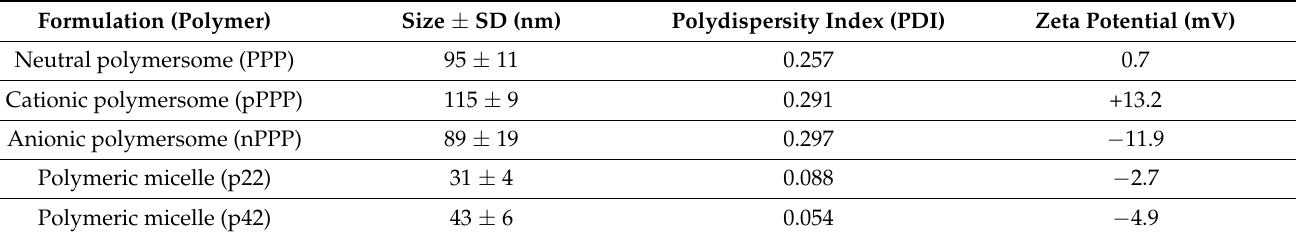
Table 1. Diameters and zeta potentials of the polymeric